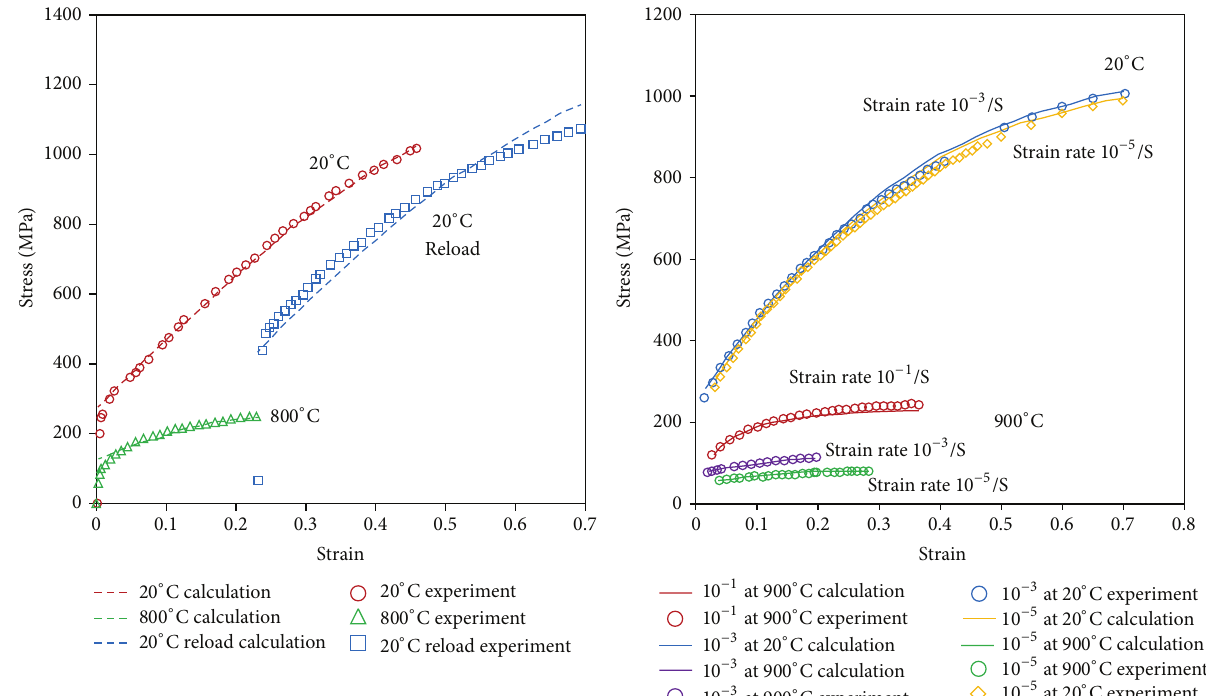
Figure 1: Load versus displacement curves for different temperatures and strain rates. Full lines: BCJ model predictions; point lines: experiments. Note that the model satisfactorily captures temperature and strain rate histories effects. The curves were extracted from Bammann et al.